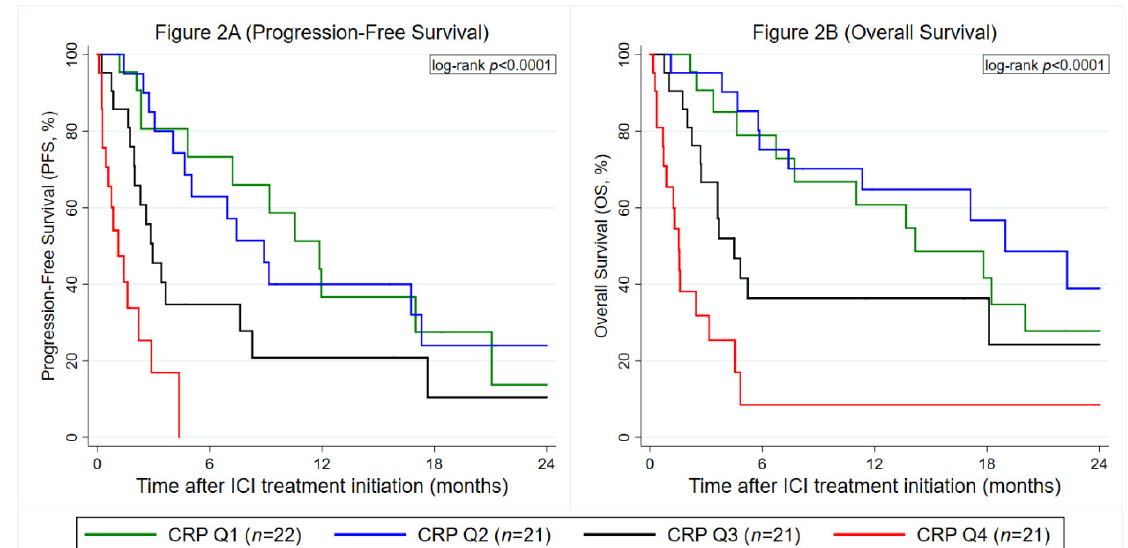
Figure 2. Prognostic association between baseline CRP levels and immune checkpoint inhibitors (ICI) treatment outcomes in the Graz cohort ( n = 85). ( A ) Progression-Free Survival. ( B ) Overall Survival. Data are only for patients with observed baseline CRP. Curves were estimated with Kaplan–Meier estimators. The left panel (Figure 2A) depicts a PFS analysis and the right panel (Figure 2B) an OS analysis, respectively. CRP cutoffs were as follows: Q1: CRP ≤ 7.7 mg/L, Q2: CRP > 7.7 mg/L, but ≤ 21.6 mg/L, Q3: CRP > 21.6 mg/L, but ≤ 66.1 mg/L and Q4: CRP > 66.1 mg/L. Abbreviations: PFS—